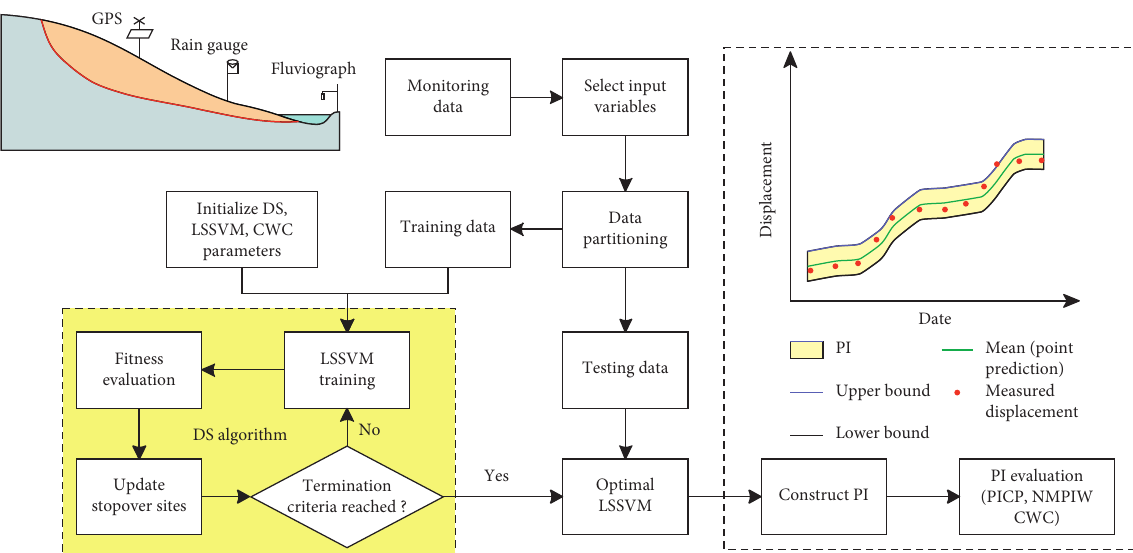
Figure 9: Flowchart of the DS-LSSVM method for PI construction for landslide